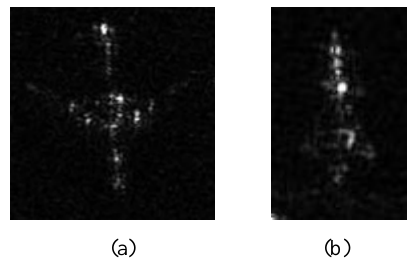
Figure 1. Aircraft chips. (a) Type A. (b) Type B.